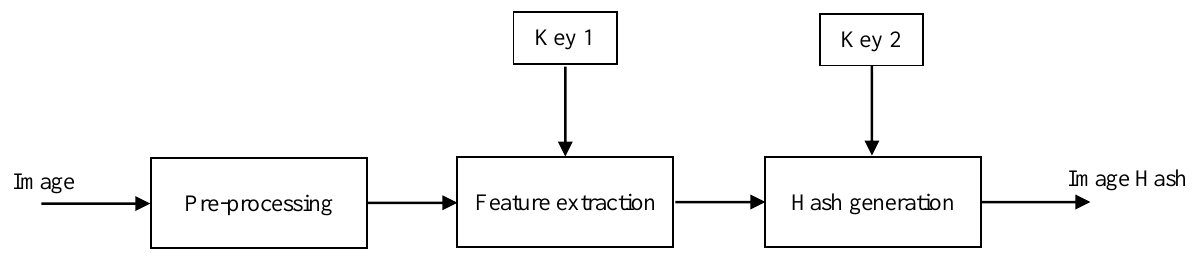
Figure 3. Block diagram of the proposed hashing